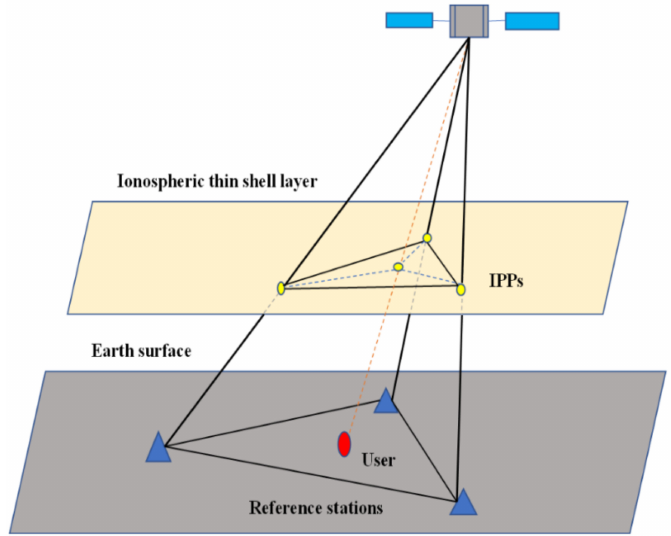
Figure 2. DIM interpolation